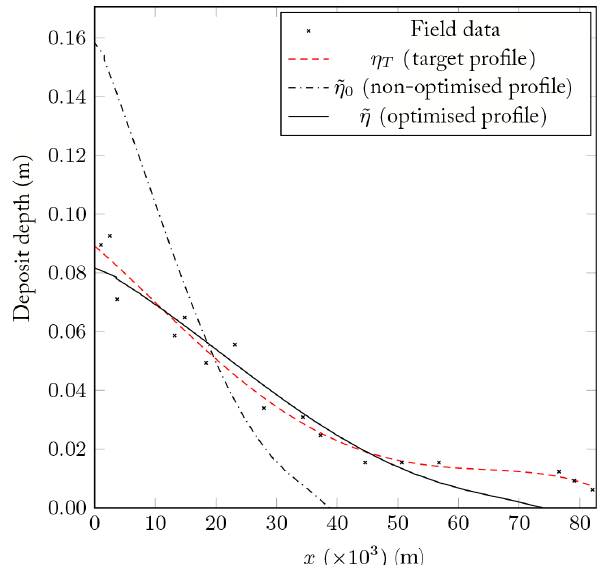
Figure 7. The dimensional deposit output e η 0 from the initial param- eter guess (Eq. 74) and the optimised dimensional deposit output e η from the optimised parameter (Eq. 77) shown against the field mea- surement from Bed 1.1 (Talling et al., 2007a) and the fourth-order polynomial target deposit profile, η T